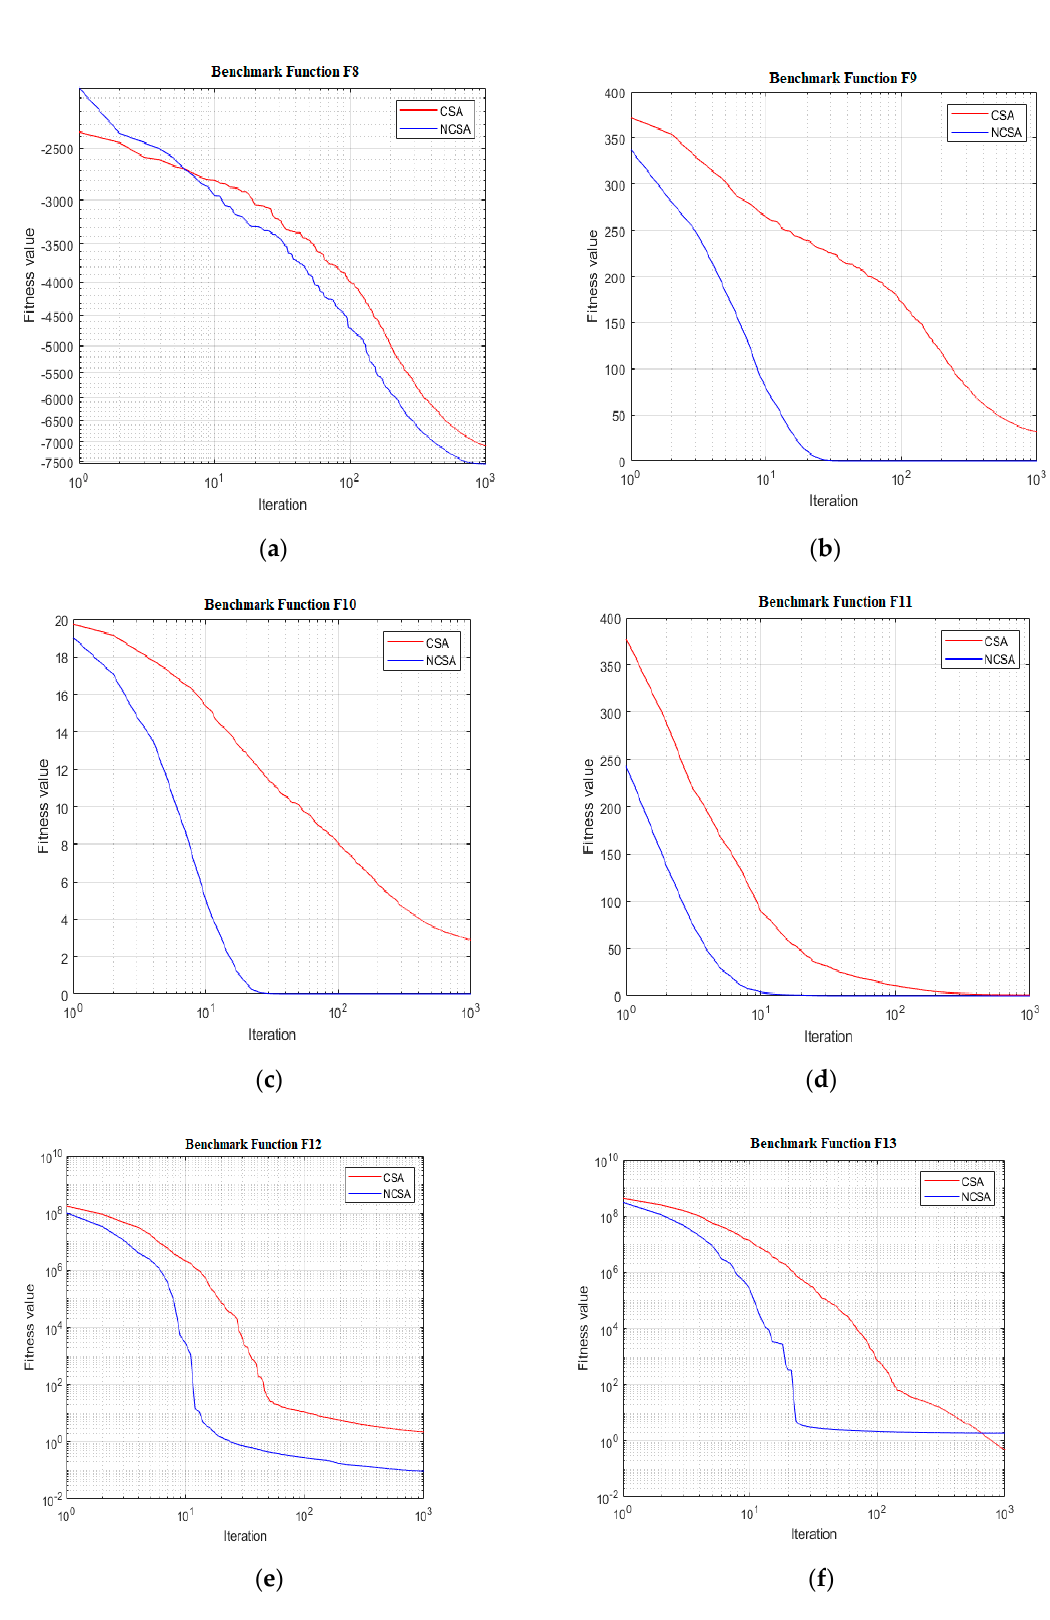
Figure 5. Convergence curve for CSA and NCSA for Multimodal Benchmark function f 8 – f 13 ( a – f ), ( a ) f 8 benchmark function, ( b ) f 9 benchmark function, ( c ) f 10 benchmark function, ( d ) f 11 benchmark function, ( e ) f 12 benchmark function and ( f ) f 13 benchmark function.